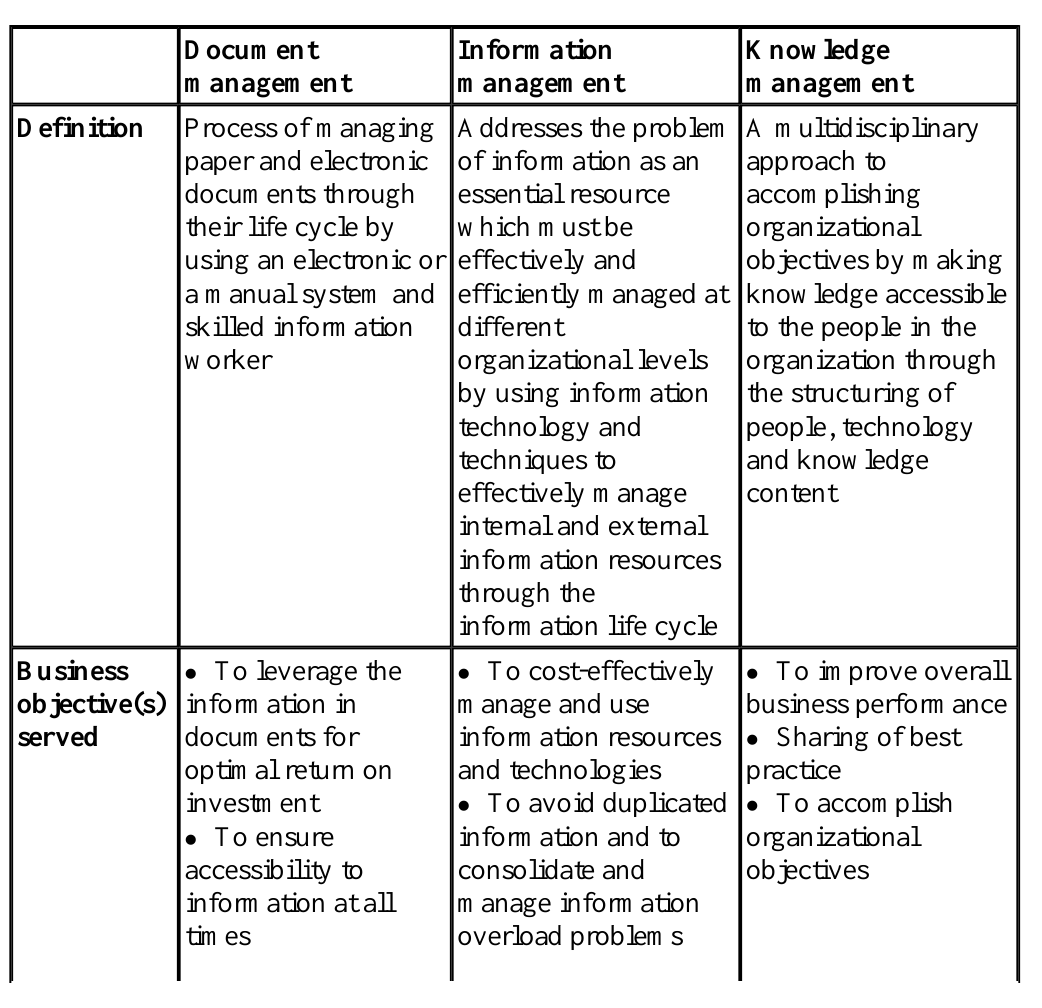
Table 2 Comparison of document management, information management and